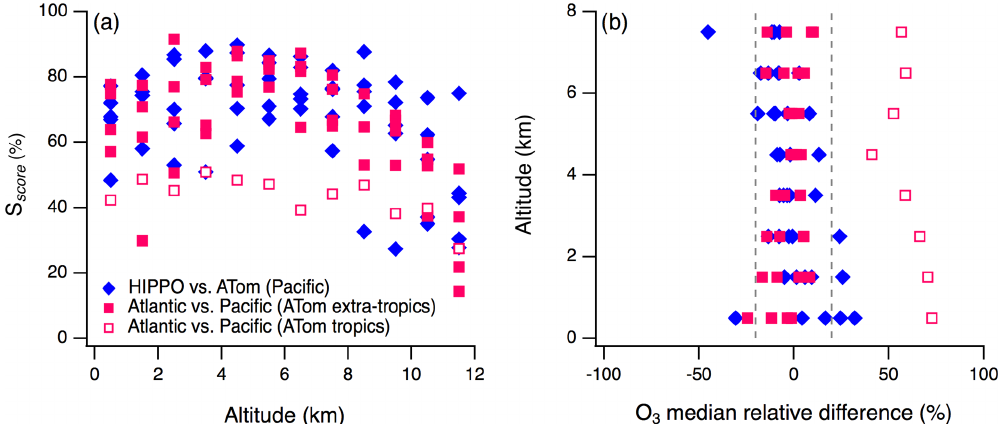
Figure 11. All S score values from Fig. 10 are shown in panel (a) and are plotted against altitude. The HIPPO and ATom comparison in the Pacific Basin is shown using blue diamonds, and a comparison of the Atlantic and Pacific basins during ATom is shown using filled pink squares for the extra-tropics and open pink squares for the tropics. The relative difference of median O 3 from 0 to 8km given in Fig. 10 is shown in panel (b) , using the same color and marker code as in panel (a) . The dotted gray lines indicate a relative difference of